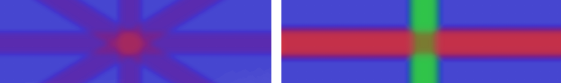
Figure 4: Example of fusion. First, four rays with an important uncertainty. The confidence at the intersection is much higher. Then, a fusion with both a strong confidence to be empty and occupied . The confidence at the intersection is equal to 0 . 5 for both input, the unknown label remains small.